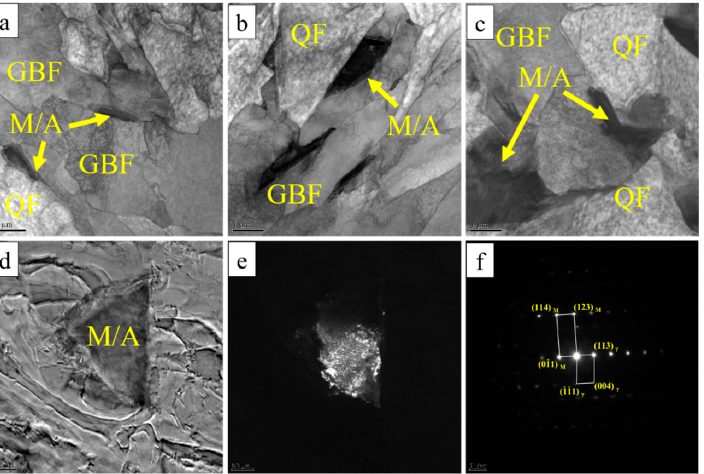
Figure 8. TEM observations for samples comprising ( a ) 0.15 wt.% Si, ( b ) 0.36 wt.% Si, and ( c ) 0.77 wt.% Si. Figure ( d ) and ( e ) represent the bright and dark fields of the M/A constituent, and the corresponding selected area diffraction pattern is shown ( f ).